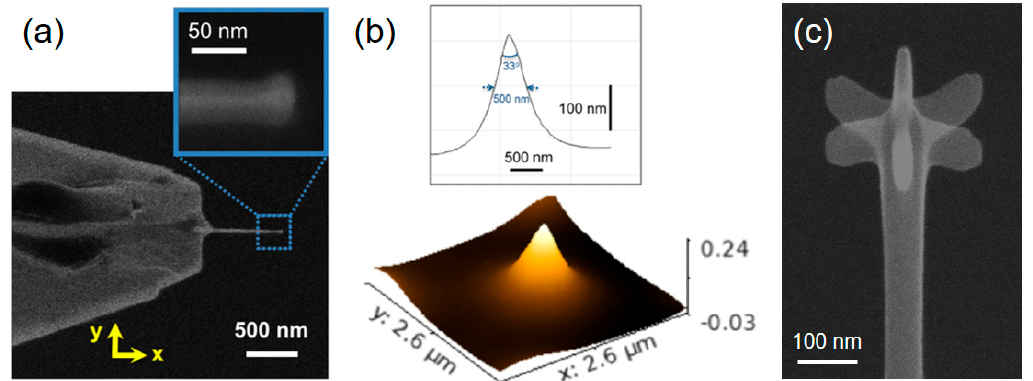
Figure 13. Non-conical apex design. ( a ) shows a truncated standard AFM tip, which was modified via Helium ion beam-induced Pt–C deposition, consisting of a 14 nm wide pillar, equipped with a hammerhead feature at the end (see upper inset). Please note, the pillar was laterally grown to reduce the width to a minimum, as shown for FEBID in Figure 3a. Such fine tips are then used for imaging shark fin structures, as shown by a 3D height scan in the lower part of ( b ). A corresponding cross-sectional profile is shown above, which reveals a measured opening angle of 33 ◦ over a height of more than 200 nm, which is very close to the real opening angle of 30 ◦ . To produce azimuthally equally distributed features at the apex, vertical growth modes are preferred, as representatively shown by the tilted SEM image of a 3D-FEBID structure in ( c ). This vertically grown tip consists of a 65 nm wide pillar, which is equipped with six radially symmetrical distributed blades with lateral expansions around 90 nm and widths of about 25 nm. At the top, a fine cone is protruding for localized detection of vertical sample interactions. ( a , b ) were adapted and reprinted from Nanda et al., J. Vac. Sci. Technol. B 2015 [137].